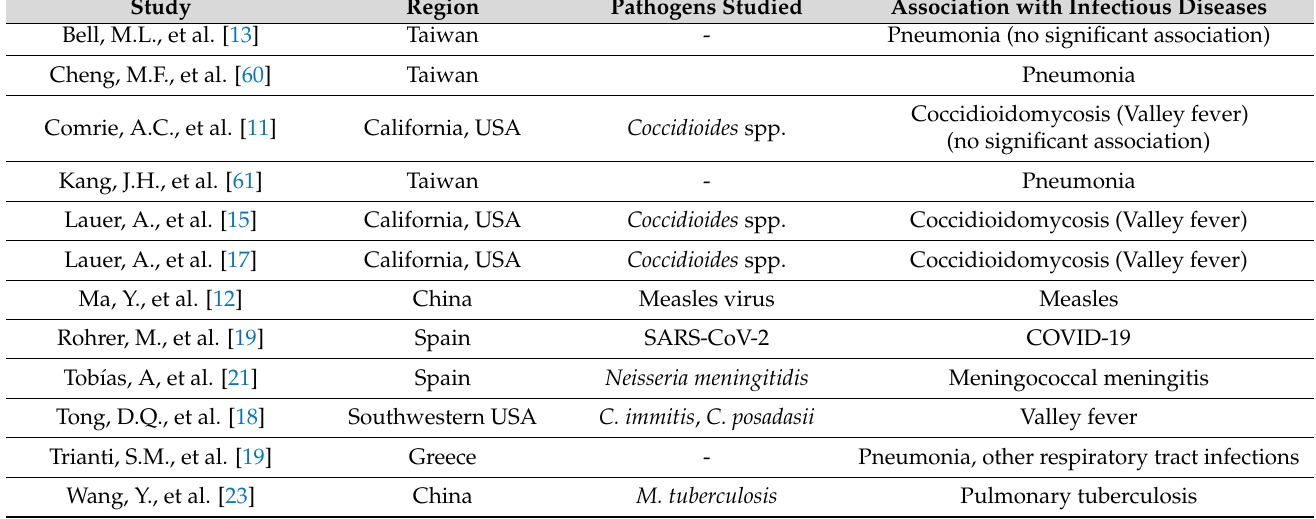
Table 2. Desert dust events associated with infectious disease